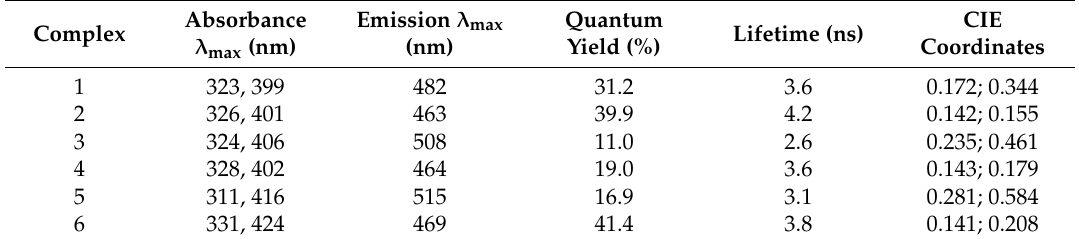
Table 2. UV–Vis, photoluminescence spectra data for title complexes in solid state.